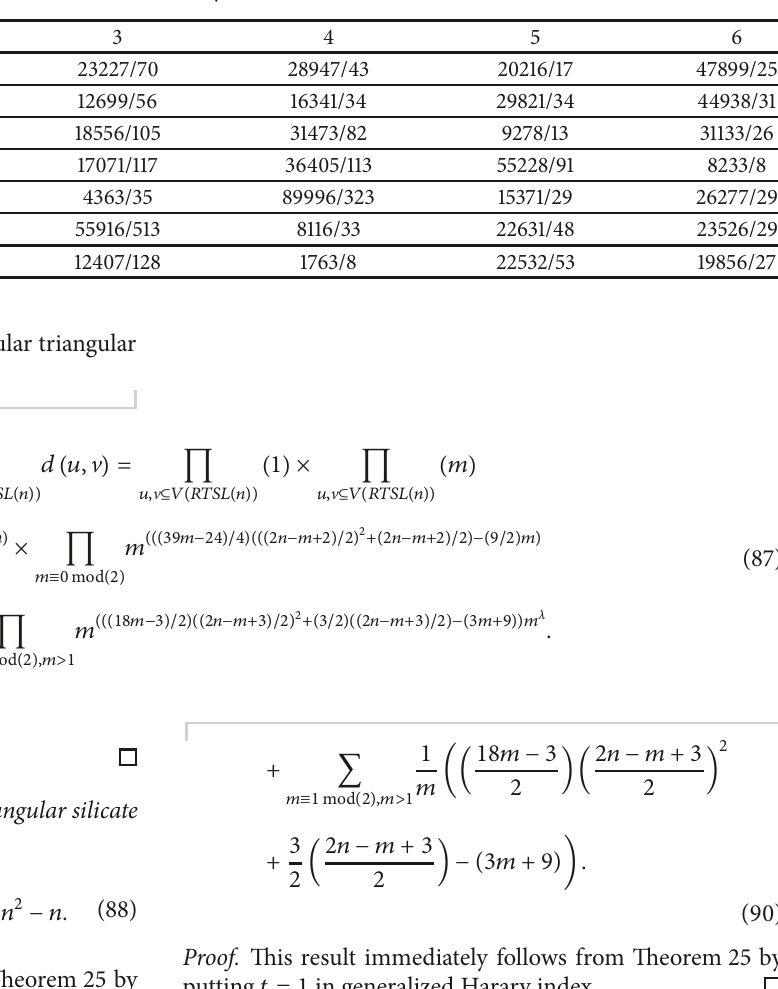
Table 12: Generalized Harary index of 𝑅𝑇𝑆𝐿